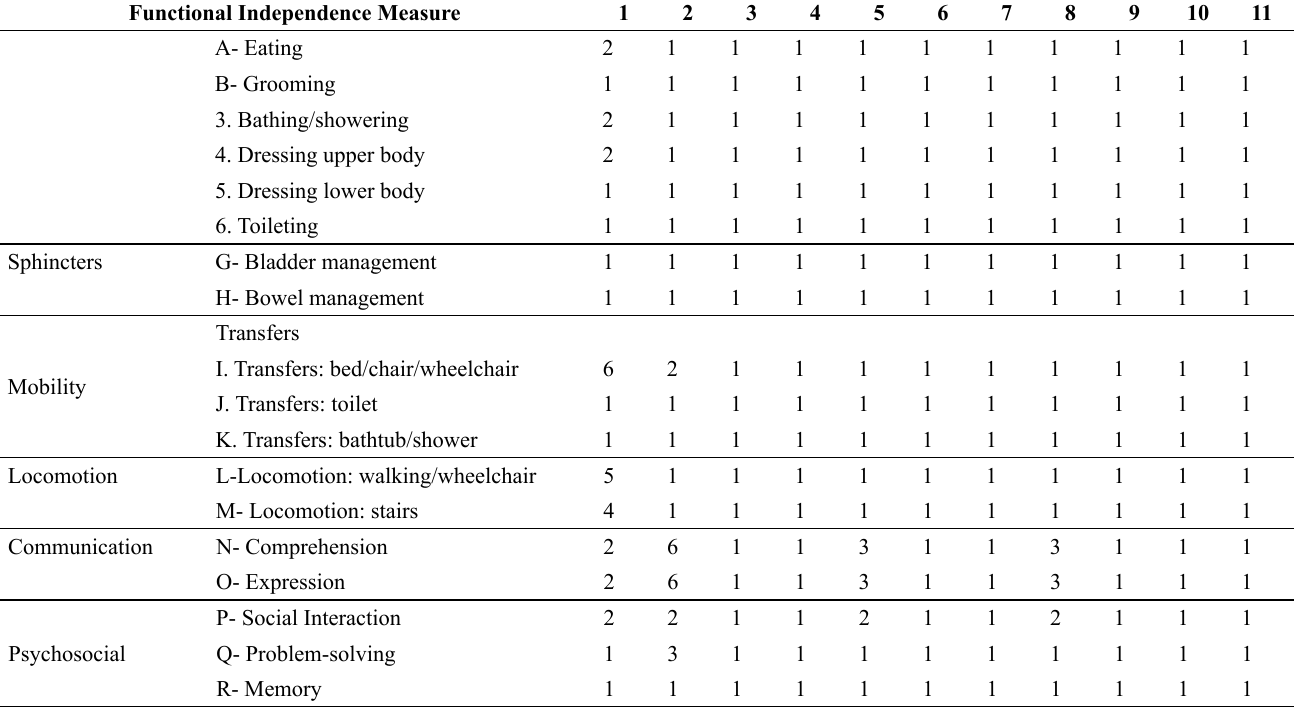
Locomotion L-Locomotion: walking/wheelchair Communication N- Comprehension